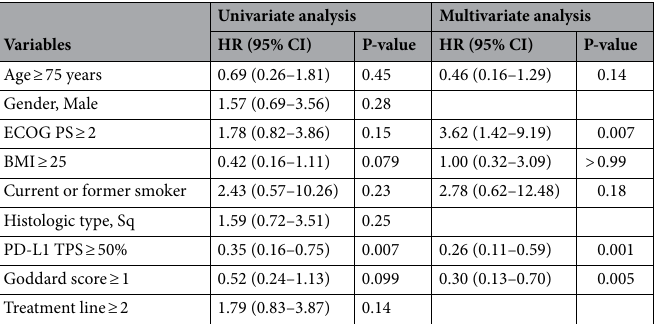
Table 4. Univariate and multivariate analysis of risk factors related to overall survival. Sq squamous cell carcinoma, ECOG PS Eastern Cooperative Oncology Group performance status, BMI body mass index, TPS tumor proportion